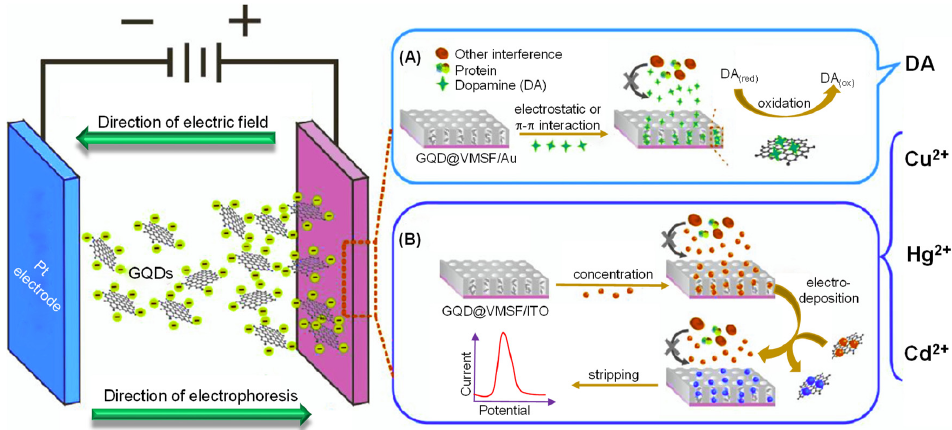
Figure 17. ( A ) Casting procedure of GQD@VMSF (vertically-oriented mesoporous silica-nanochannel film) modified electrode via electrophoresis. ( B ) Quantification of Cu 2+ , Hg 2+ and Cd 2+ ions as well as dopamine. Adapted from Lu et al. [275].